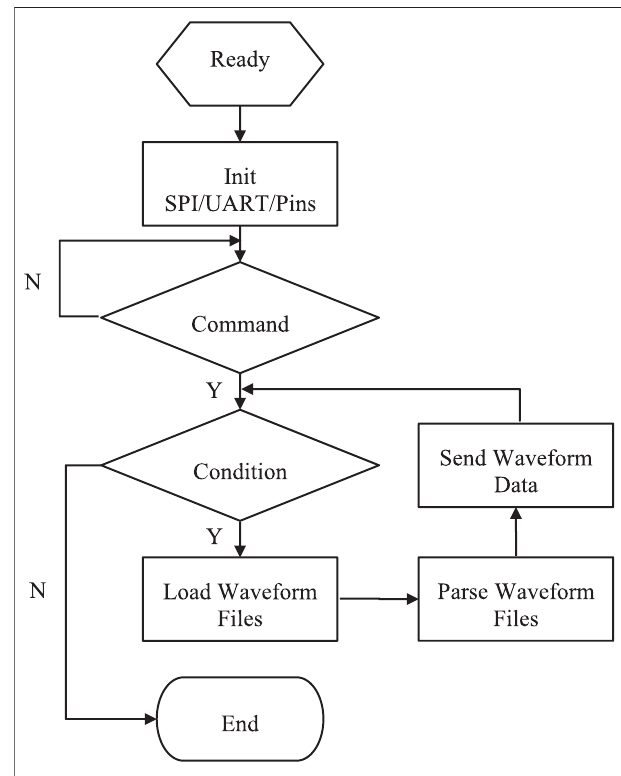
FIGURE 5 | The fl ow chart of the driving program. When the program starts to run, the initialization operation is performed fi rst. Then the system enters the command waiting interface. Finally, the corresponding operations are executed according to command